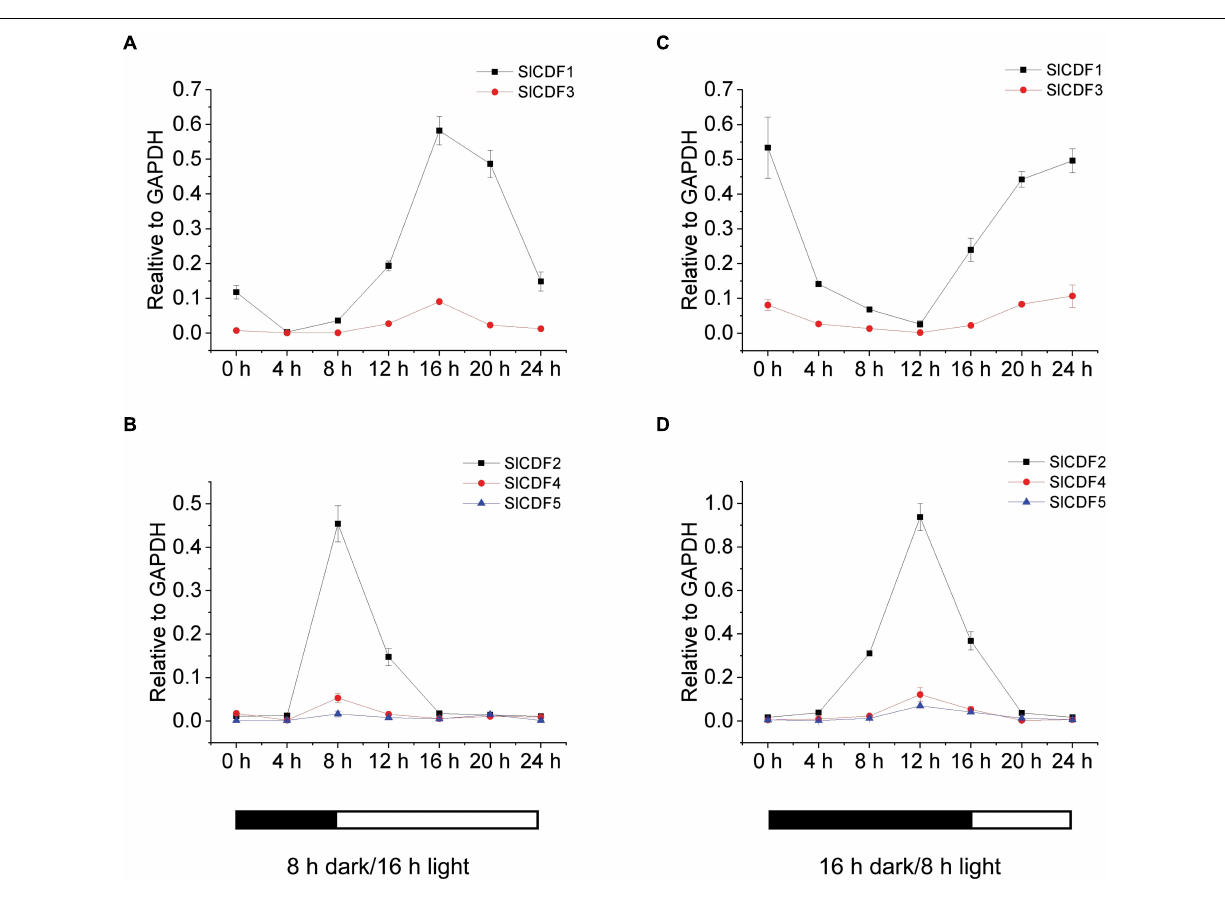
LD and SD conditions ( Figure 4C ). Compared with wild- type plants, SlSP5G expression in SlCDF3